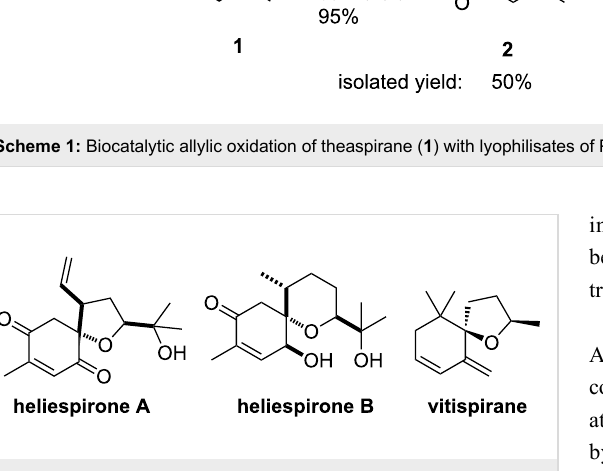
Figure 2: Selected bioactive terpenoids based on spiroether back- bones